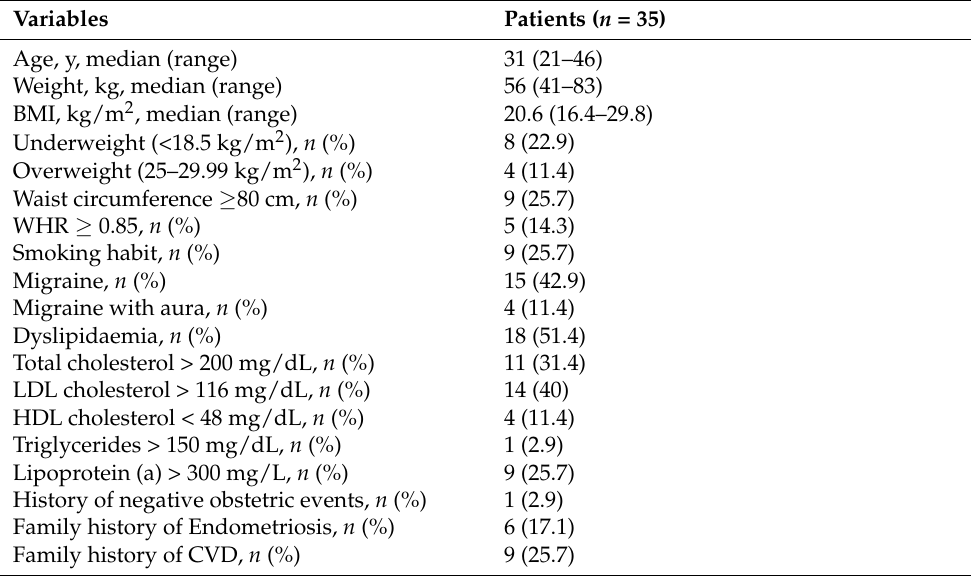
Table 1. Baseline Characteristics of the Study